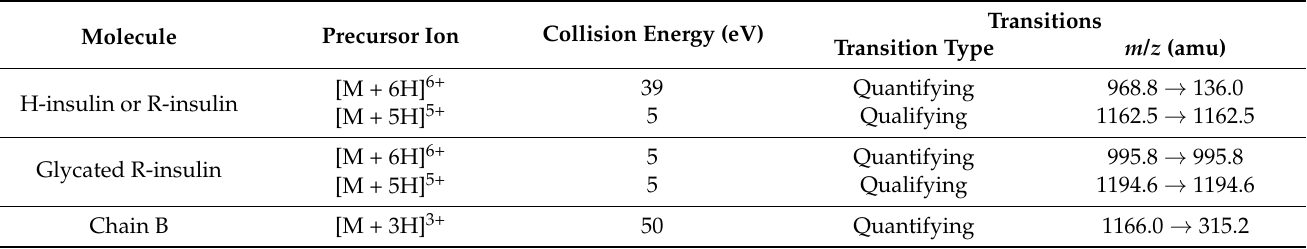
Table 1. Operating parameters, multiple reaction monitoring (MRM) transitions, and collision energies.